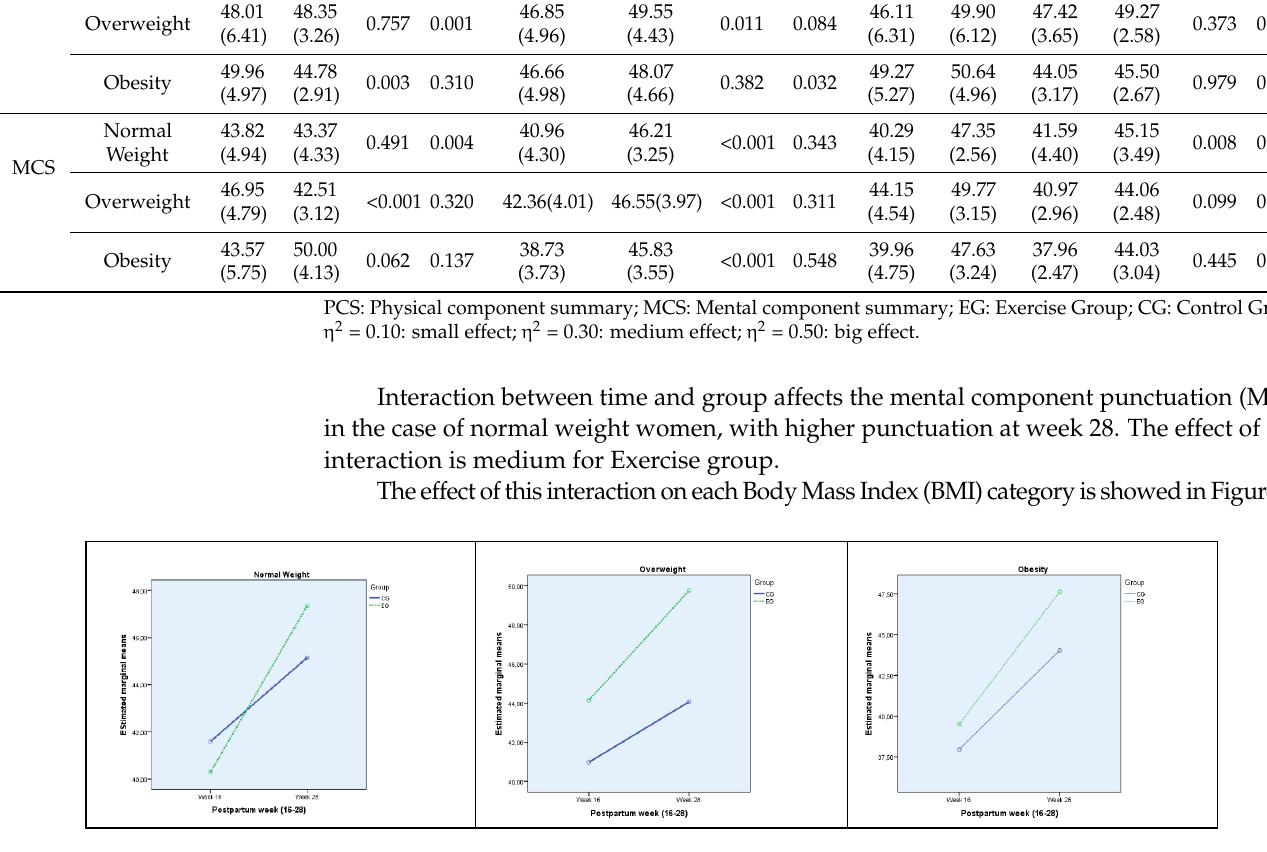
Figure 3: Marginal population means estimated for each week for each MCS group according to BMI. MCS: sum of mental components punctuation; EG: Exercise Group; CG: Control Group.